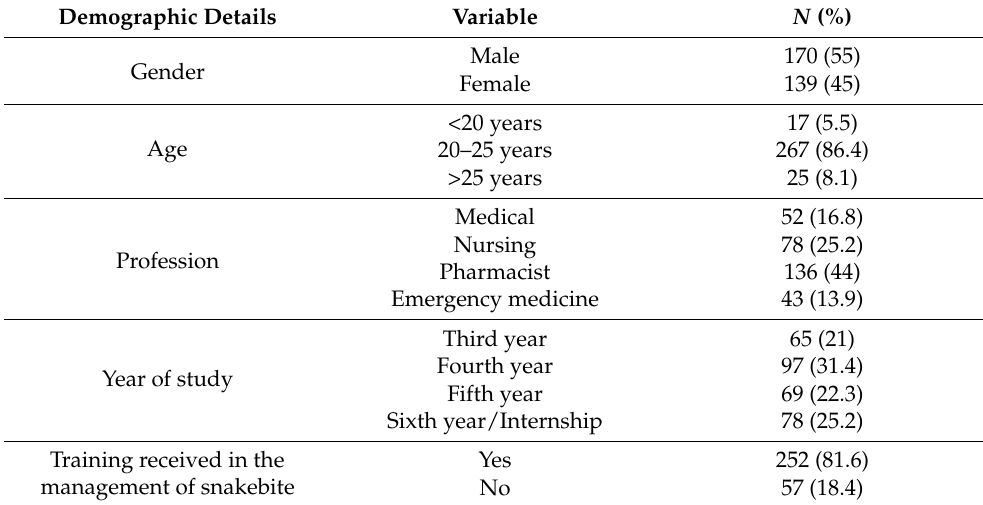
Table 2. Respondents’ Characteristics.